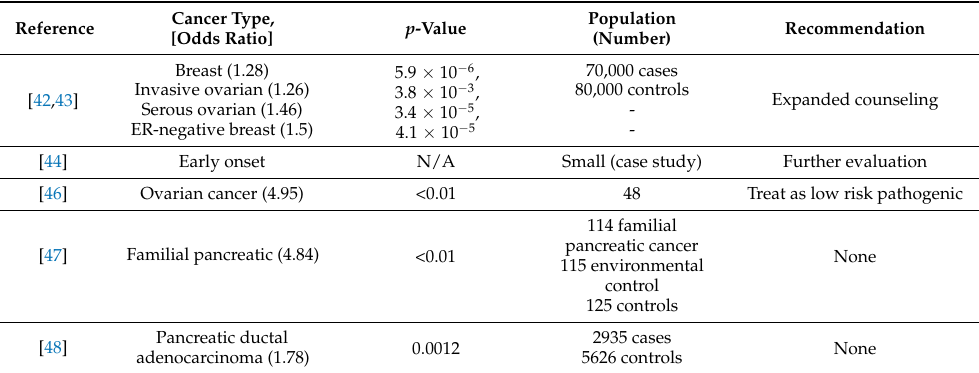
Table 1. K3326X cancer associations: The studies of BRCA2-K3326X presented in this review are summarized here, in reference order, and with cancer type, p -value, study population size, and recommendations from the authors of the study. All studies found significant odds ratios